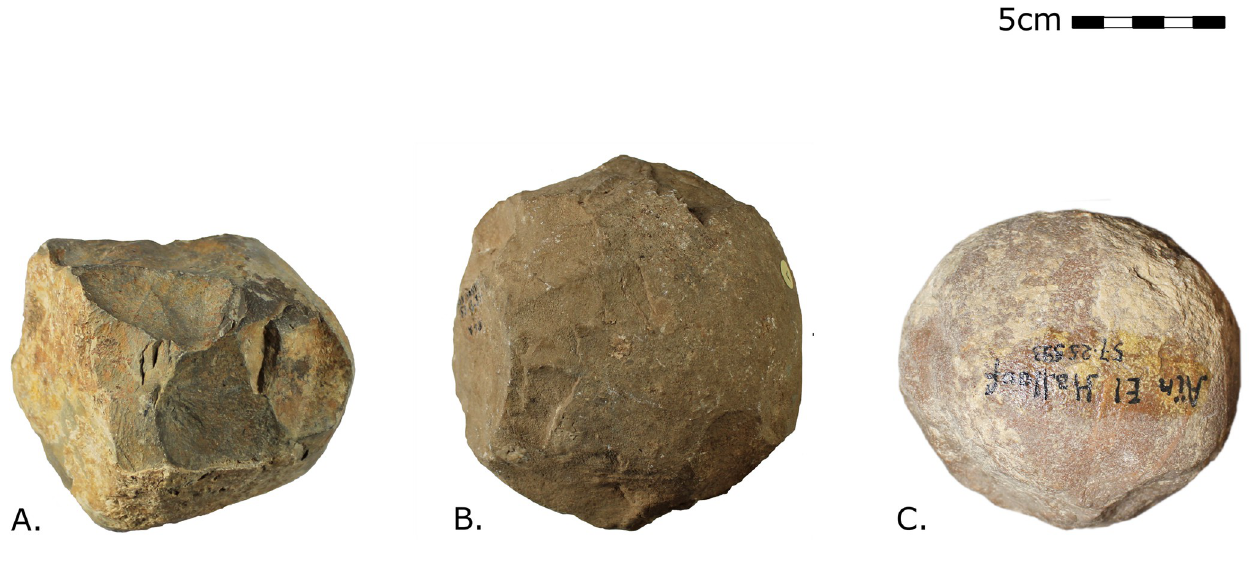
Fig 2. Illustration of the three typological categories of PSBs used in this study. (A) Polyhedron in limestone from Ain Hanech (Algeria), N˚ inv. 52.1.13, curated at the Institut de Pale´ontologie Humaine of Paris. (B) Spheroid in limestone from Ain Hanech (Algeria), N˚ inv. 53.3.3 curated at the Institut de Pale´ontologie Humaine of Paris. (C) Bola in limestone from A ï n el Hallouf (Morocco), N˚ inv. 57.25.593 curated at the Muse´e de l’Homme. Photos: Julia Caban è s.